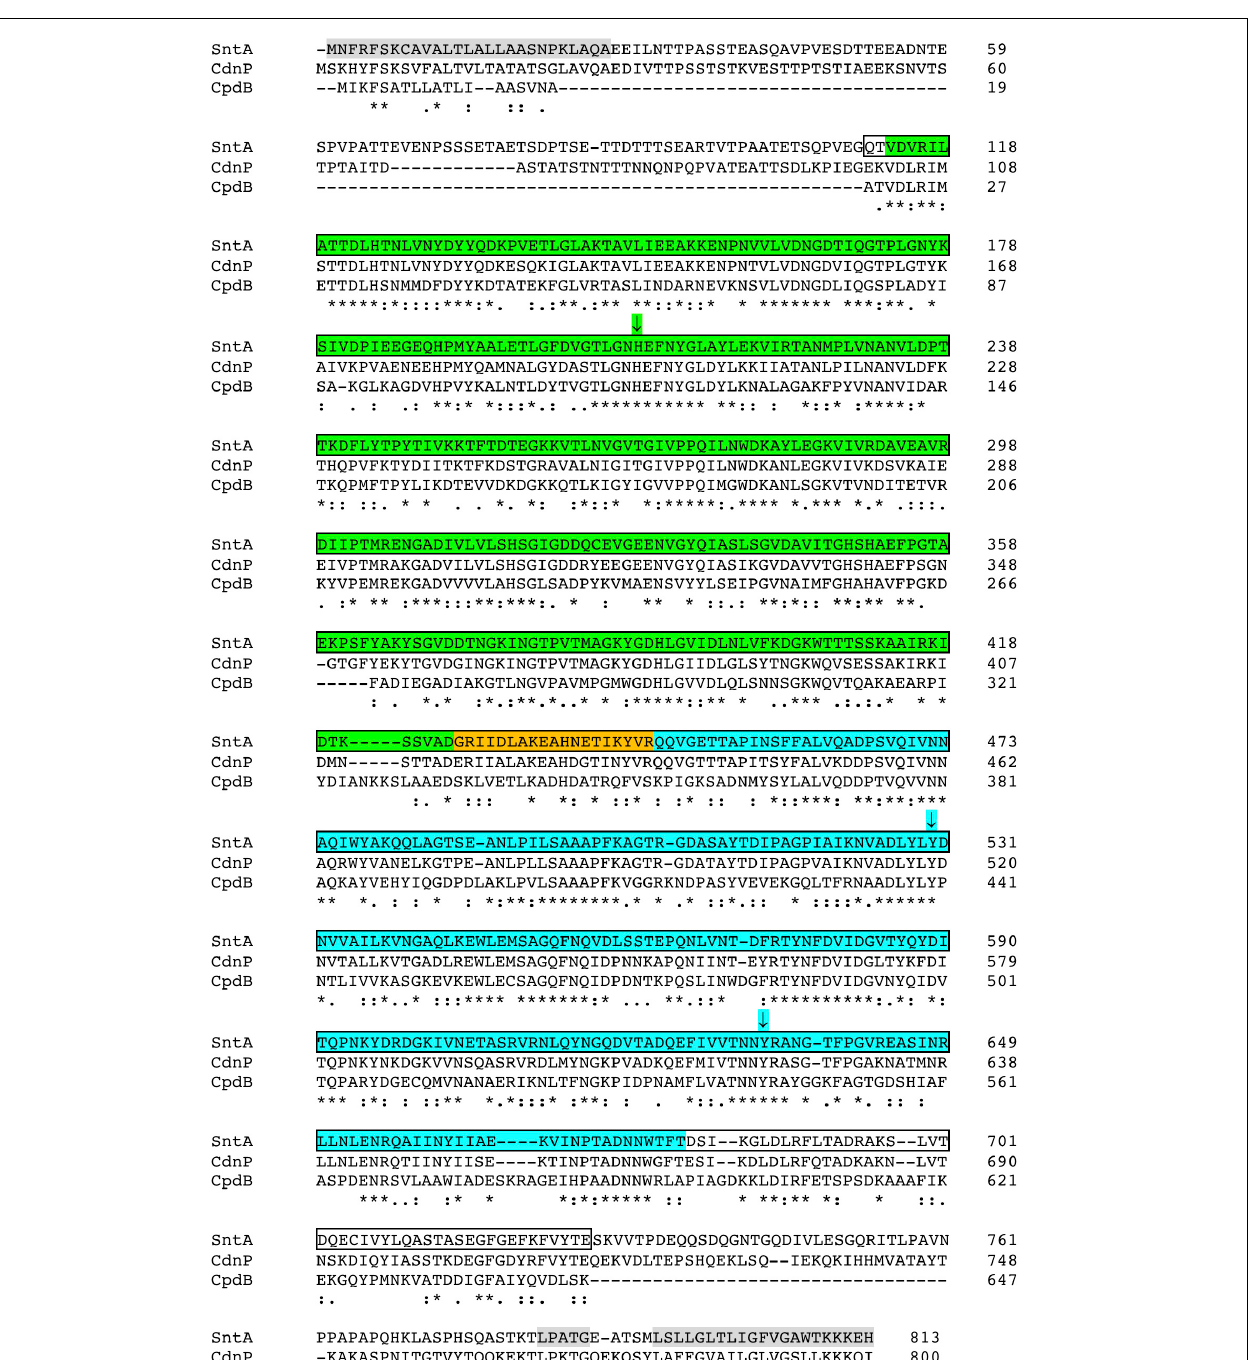
Frontiers in Microbiology |